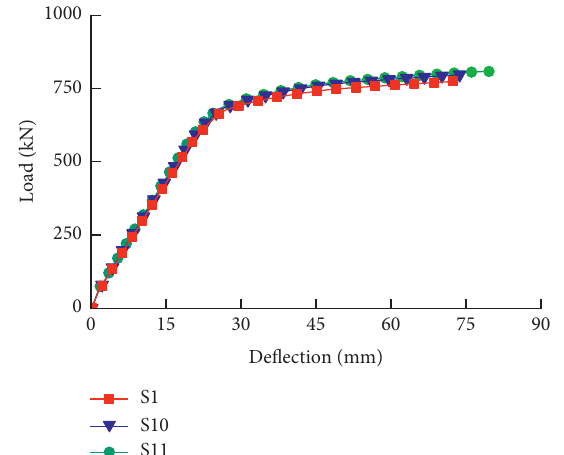
Figure 12: Load vs. midspan deflection with different widths of upper concrete